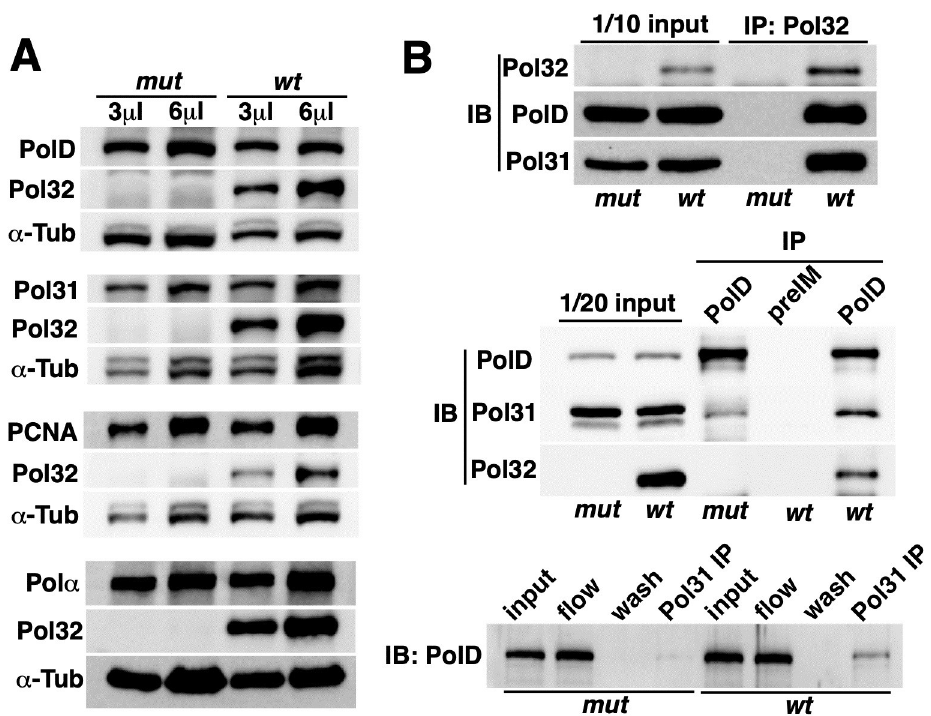
Fig 4. Interactions within the Pol δ complex. A . The level of Pol δ in wild-type and pol32 mutant embryonic extracts. Different amount of extracts (3 or 6 μ l) were used for Western blot analyses with Tubulin as a general loading control. Genotypes are on top and antibodies are listed to the left of the images. B . Co-IP experiments to detect interactions among Pol δ subunits. For each panel, the genotypes are indicated at the bottom, and the antibodies used for IP on top of the images. “preIM” indicates that the corresponding pre-Immune serum was used for IP. The antibodies used for Western blot detection (IB) are listed to the left of the panels. In the bottom panel, “input” marks the lane with 1/20 of the input extract loaded. “flow” marks the lane with a sample of “flow through” in the IP experiments loaded. “wash” denotes the lane with a sample of “wash” in the IP experiments.